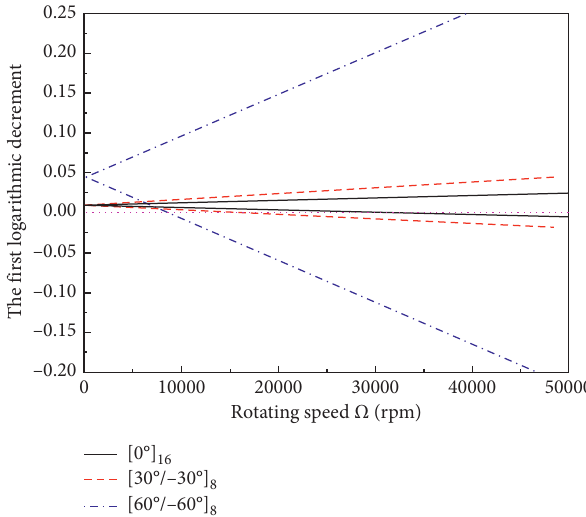
Figure 4: Variation of the first mode logarithmic decrements with rotating speed at different ply